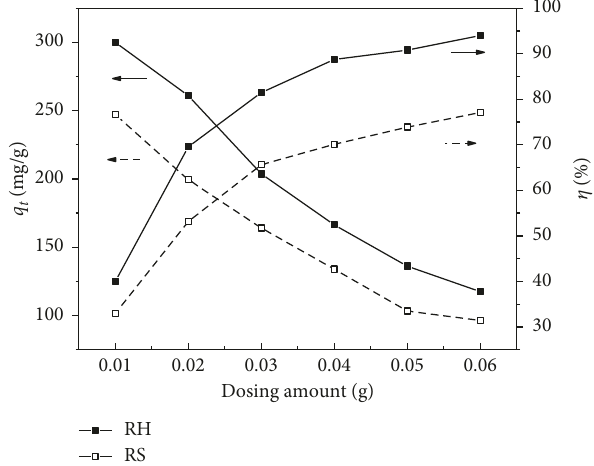
Figure 3: Effect of KRH MG.